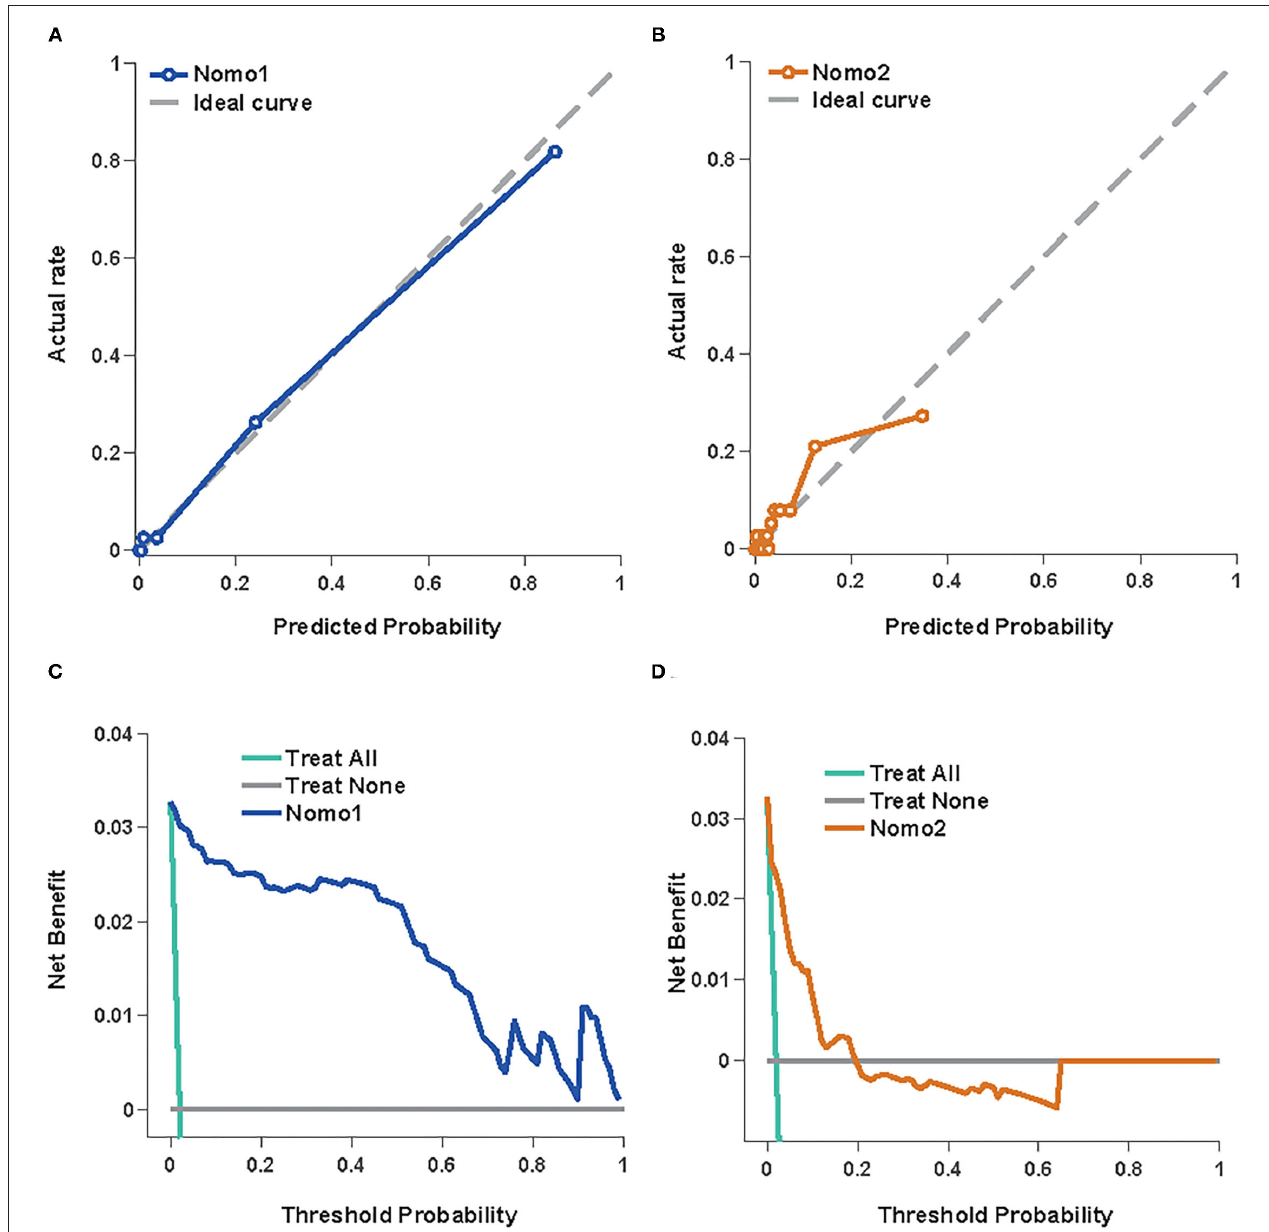
FIGURE 4 | Nomo1and Nomo2 in predicting the mortality of COVID-19 in the validation cohort. The calibration curves for Nomo1 (A) and Nomo2 (B) . A decision curve analysis for Nomo1 (C) and Nomo2 (D) .